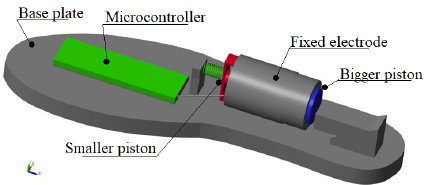
Figure 23. Matlab model of the in ‐ shoe sensor.